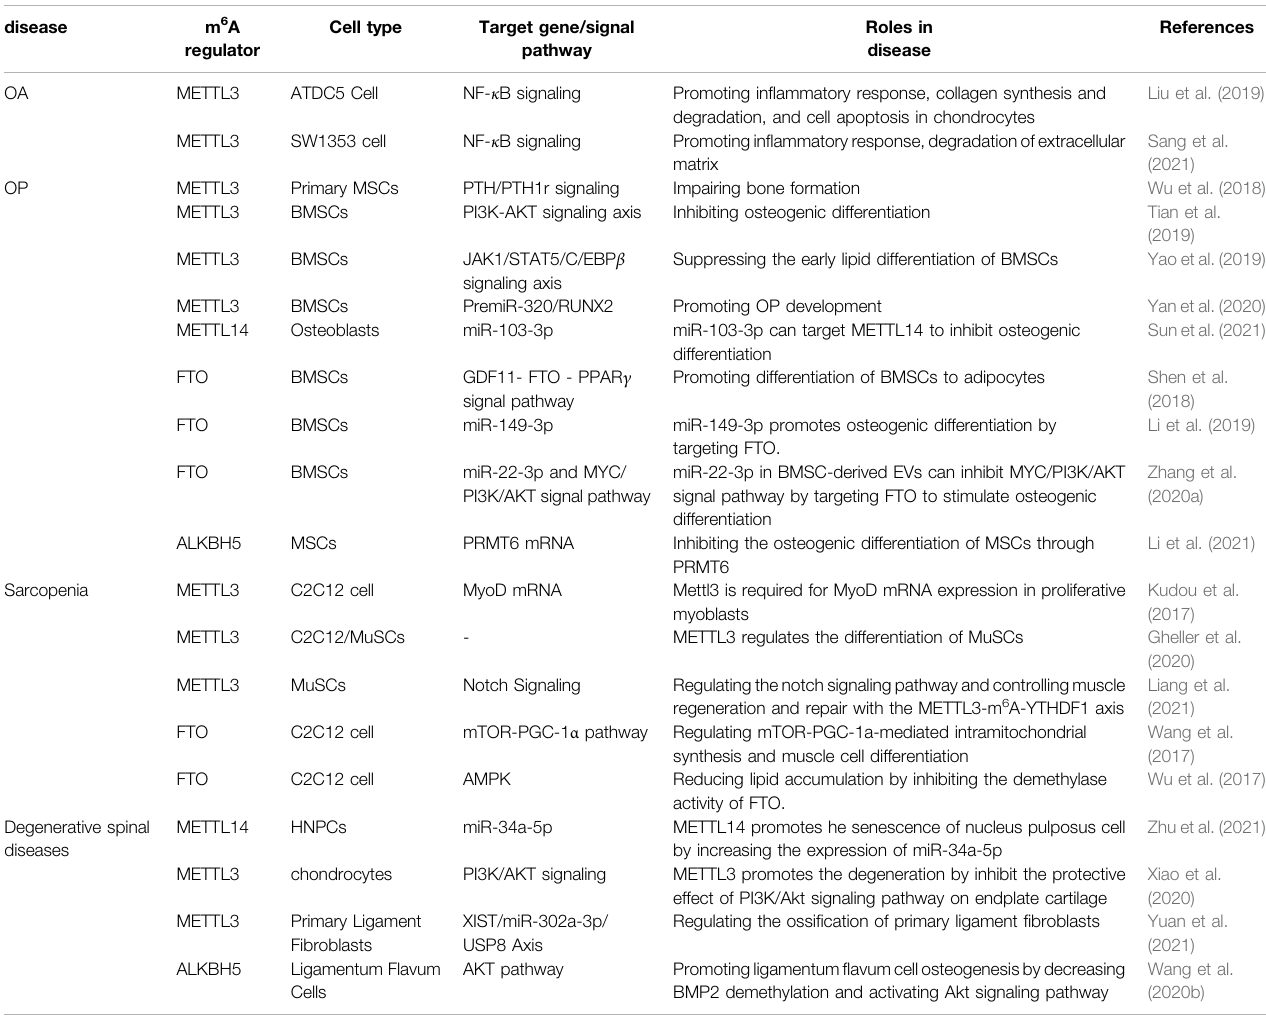
TABLE 1 | The role of m6A in degenerative musculoskeletal diseases.